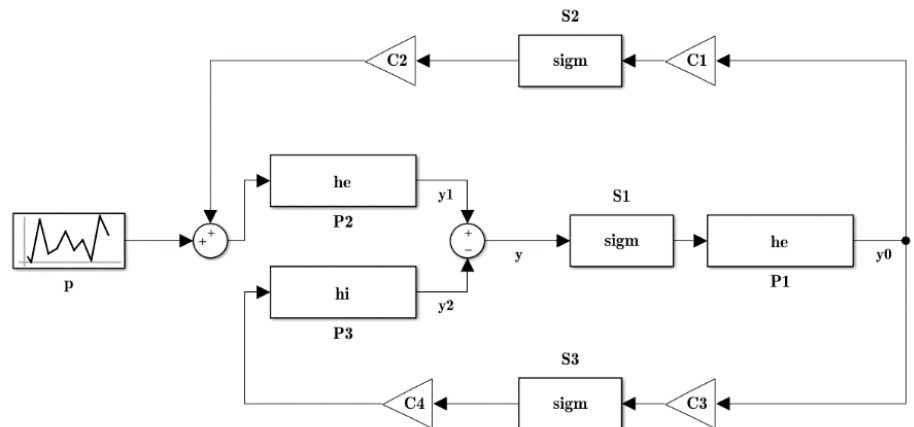
Figure 1. The one-column Jansen–Rit model. The P 1 and P 2 blocks are the functions (he) presented in Equation (1), P 3 is the function (hi) presented in Equation (2). The S 1 , S 2 , and S 3 (sigm) blocks are the sigmoidal functions presented in Equation (5), p is noise, while the C 1 – C 4 are the coefficients of connections between particular neural structures.